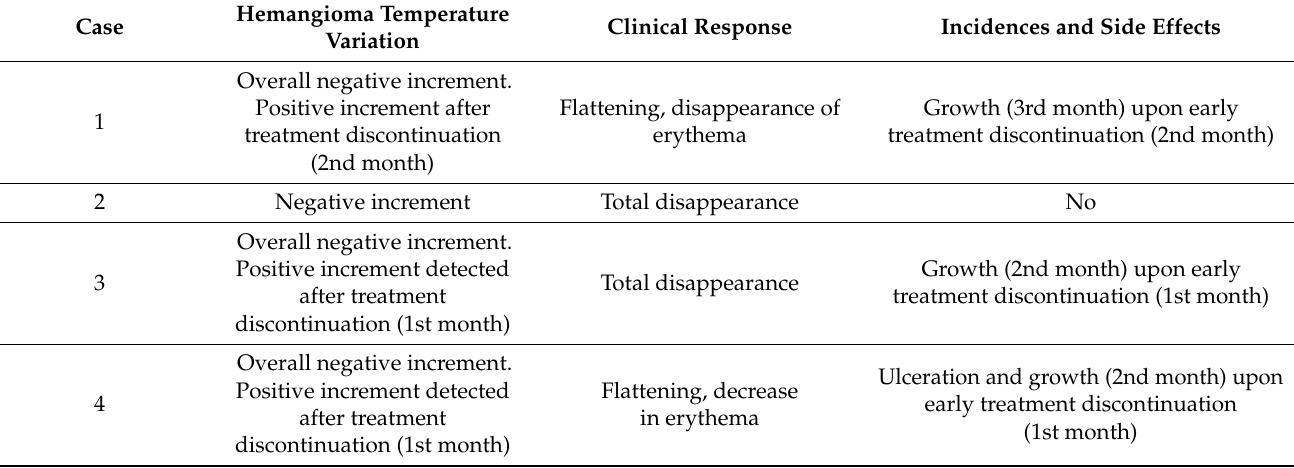
Table 4. Comparative analysis between the thermographic analysis and the response to treatment in the nine patients with IHs monitored using thermography. Temperature analysis and response to treatment concurred in all